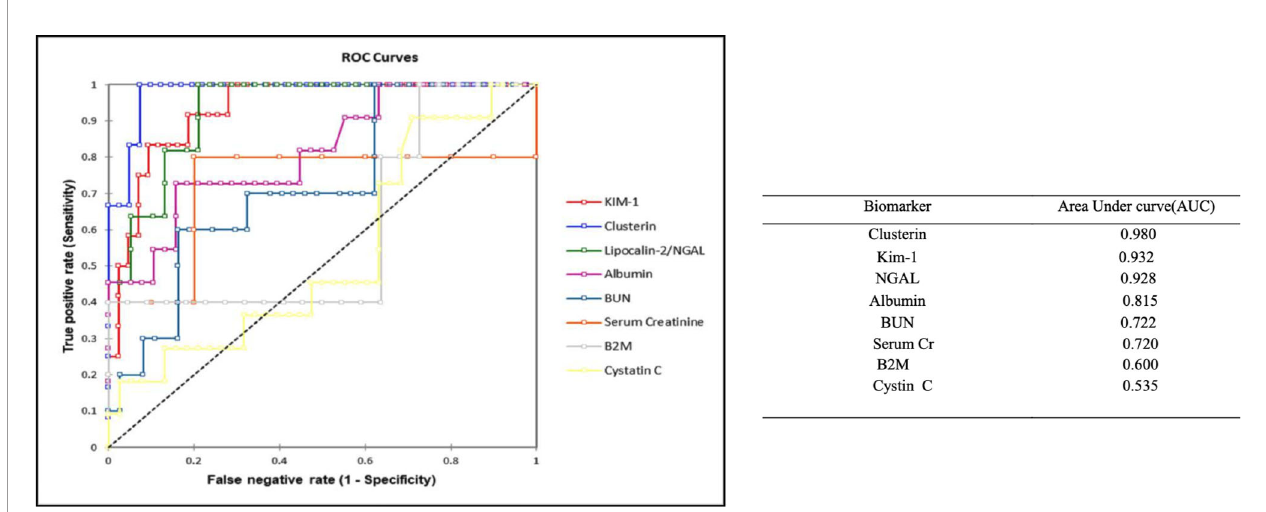
FIGURE 7 | Receiver-operator characteristics (ROC) curves for next generation urinary biomarkers compared to traditional clinical chemistry parameters. The area under the ROC curve, which serves as measure for the overall ability of a biomarker to discriminate normal (control) vs. diseased AmB and SM21 treatment (SM21 and its analogue) animals, is given in parenthesis. The pathological lesions were graded from 0 – 3 to calculate ROC. We de fi ned a ROC-AUC of 0.5 – 0.6 as showing no predictive ability, a ROC-AUC of 0.6 – 0.7 as showing poor predictive ability, a ROC-AUC of 0.7 – 0.8 as showing fair predictive ability, a ROC-AUC of 0.8 – 0.9 as showing good predictive ability, and a ROC-AUC above 0.9 as showing outstanding predictive ability. An excellent diagnostic performance in our study for clusterin and Kim-1 (AUC- 0.98 and 0.932, respectively) to evaluate comparative nephrotoxicity of AmB compared to control groups and SM21 treatment group [These binomially plotted ROC curves were created using XLSTAT software (Addinsoft, Microsoft)]. Kim-1, Kidney injury molecule-1; NGAL, Neutrophil gelatinase-associated lipocalin; b 2M, b macroglobulin; AmB, Amphotericin B.